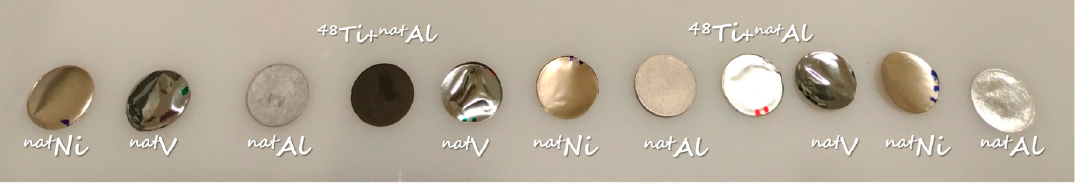
Figure 8. Photograph of a typical stacked-foils target of the PASTA project.